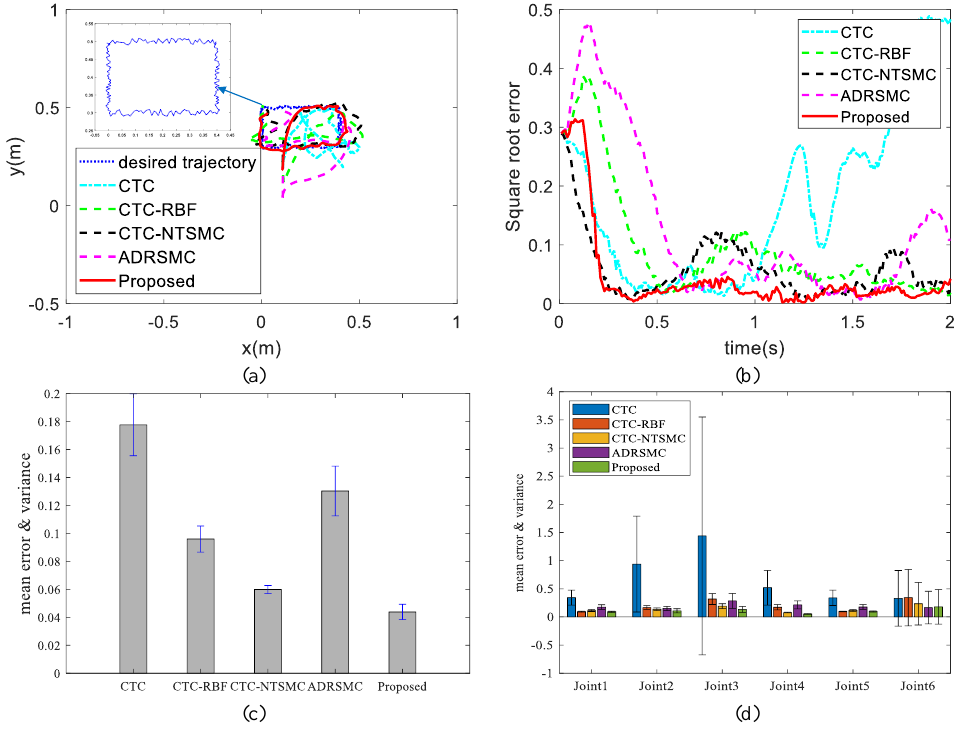
Figure 10. Tracking and comparison results of the non-uniform rectangular trajectory with joint measurement noises. ( a ) end motion trajectories, ( b ) square root errors, ( c ) mean errors and variances of whole process, ( d ) mean errors and variances of each joint